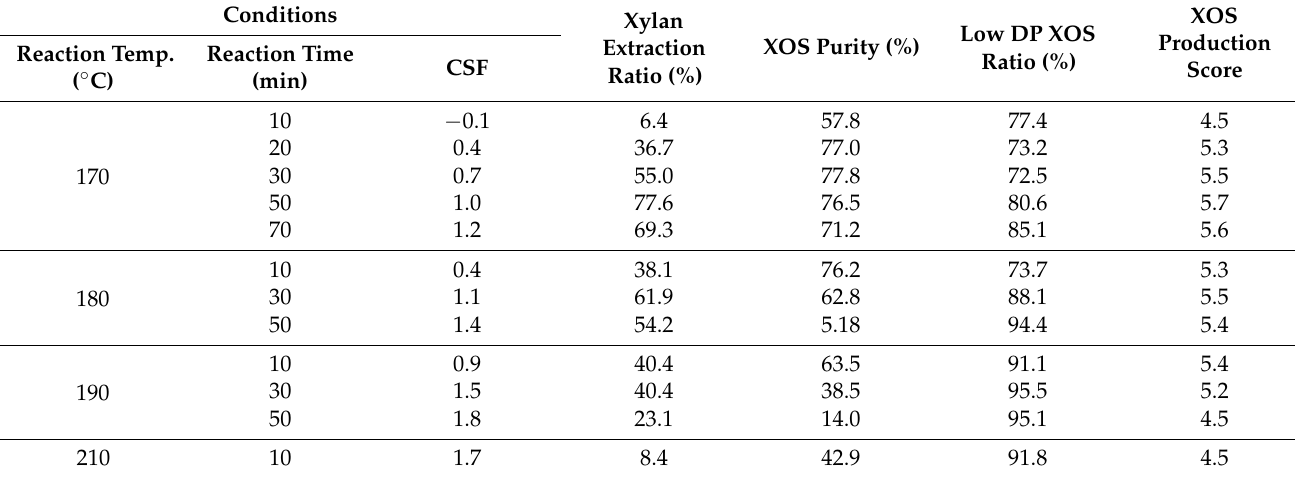
Table 4. Xylan extraction ratio, XOS purity, low DP XOS ratio (%), and XOS production score with LHW treatment conditions. Conditions Xylan Extraction Ratio